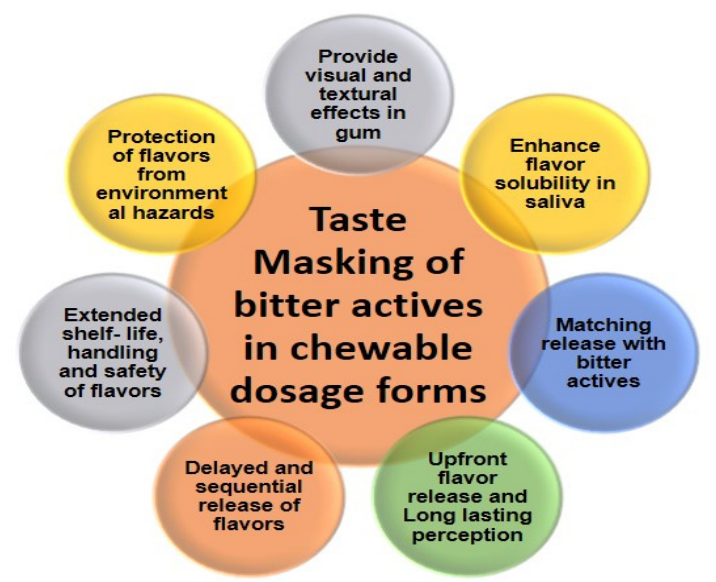
Figure 8. Advantages of Flavor microencapsulation in chewing gums.